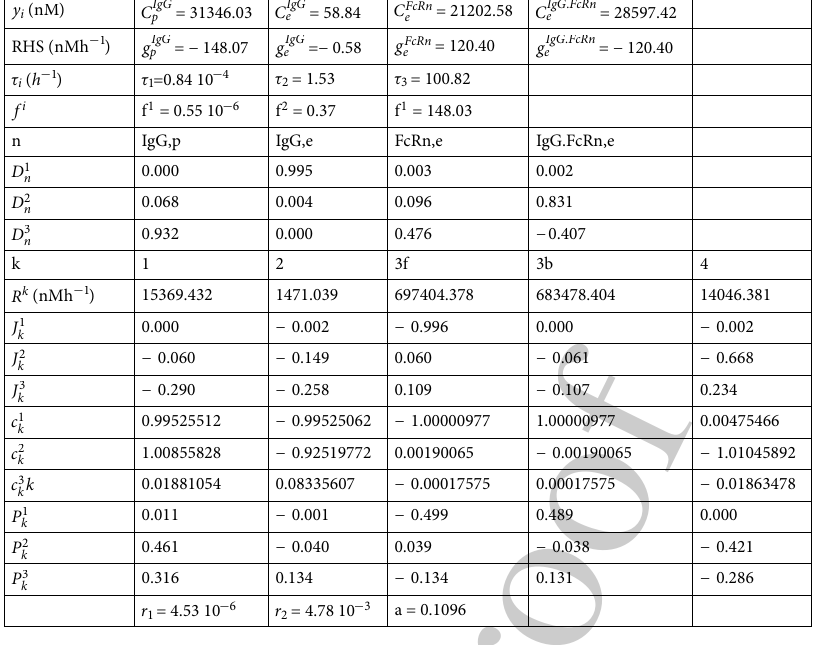
Table 4. Solution data and CSP diagnostics at t = 10 2 h , where M = 2